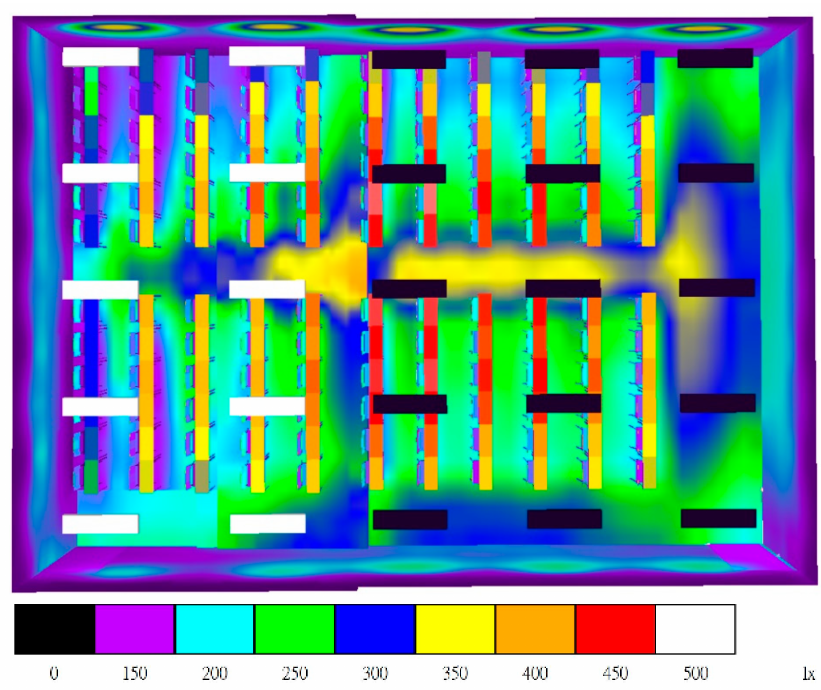
Figure 10. Color rendering of TR-214 classroom before lighting improvement.